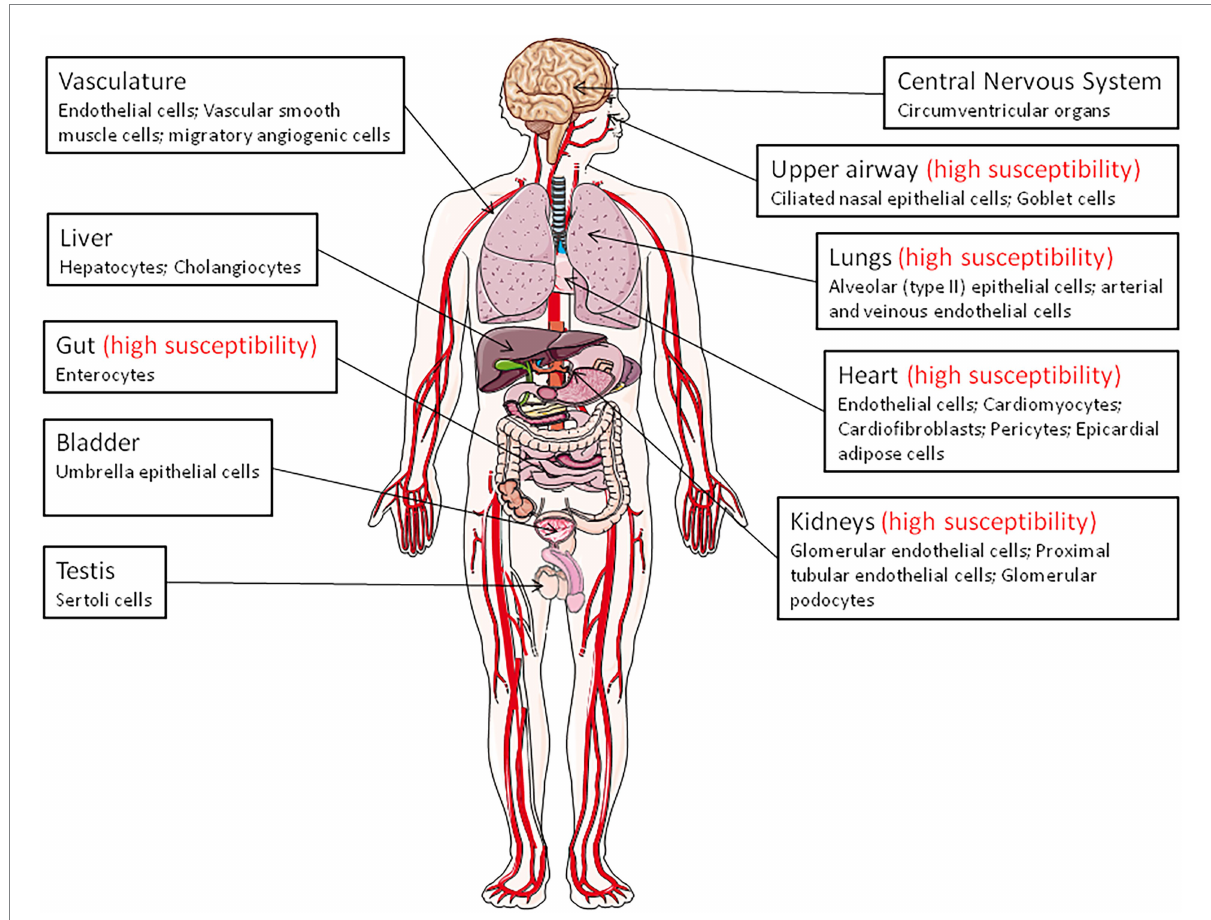
FIGURE 1 Angiotensin-converting enzyme 2 (ACE2) expression throughout the body (the main ACE2 + target cells are indicated). The organs vulnerability to SARS-CoV-2 infection is also indicated (high